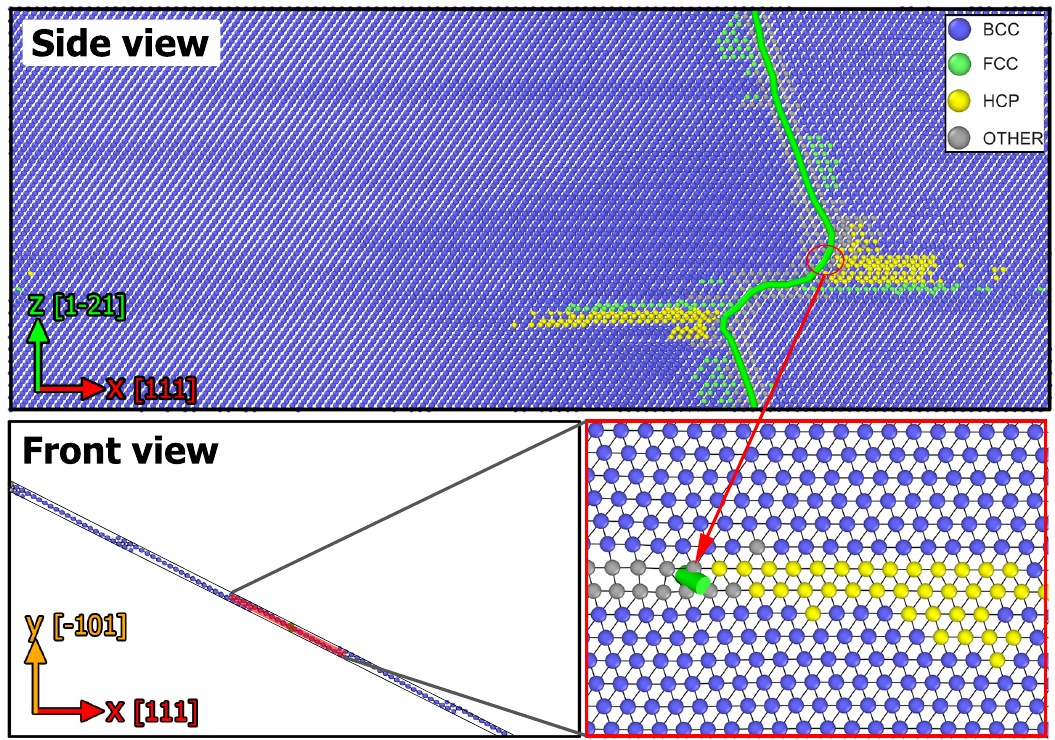
Figure 10. Snapshots showing side view, front view and a cross section of the dislocation (in green) and surrounding atoms at strain of 3% (30 ps). The side view shows the buckling of surrounding atoms and the nucleation of the hcp phase with a closer look of the nucleation of the hcp phase on the ( 0¯11 ) plane. Atoms are colored according to crystal structure types (blue, bcc; green, fcc; yellow, hcp; grey, disordered